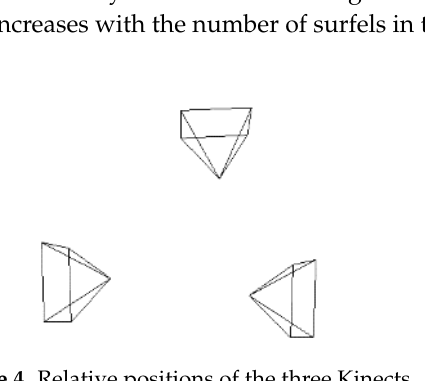
( a ) ( b ) Figure 5. Comparison of single-camera SLAM result and three-camera SLAM result. ( a ) is a single- camera SLAM result, the movement trajectory is in orange. ( b ) is a three-camera SLAM result with the same movement trajectory as ( a ), different colors mean different camera trajectories.